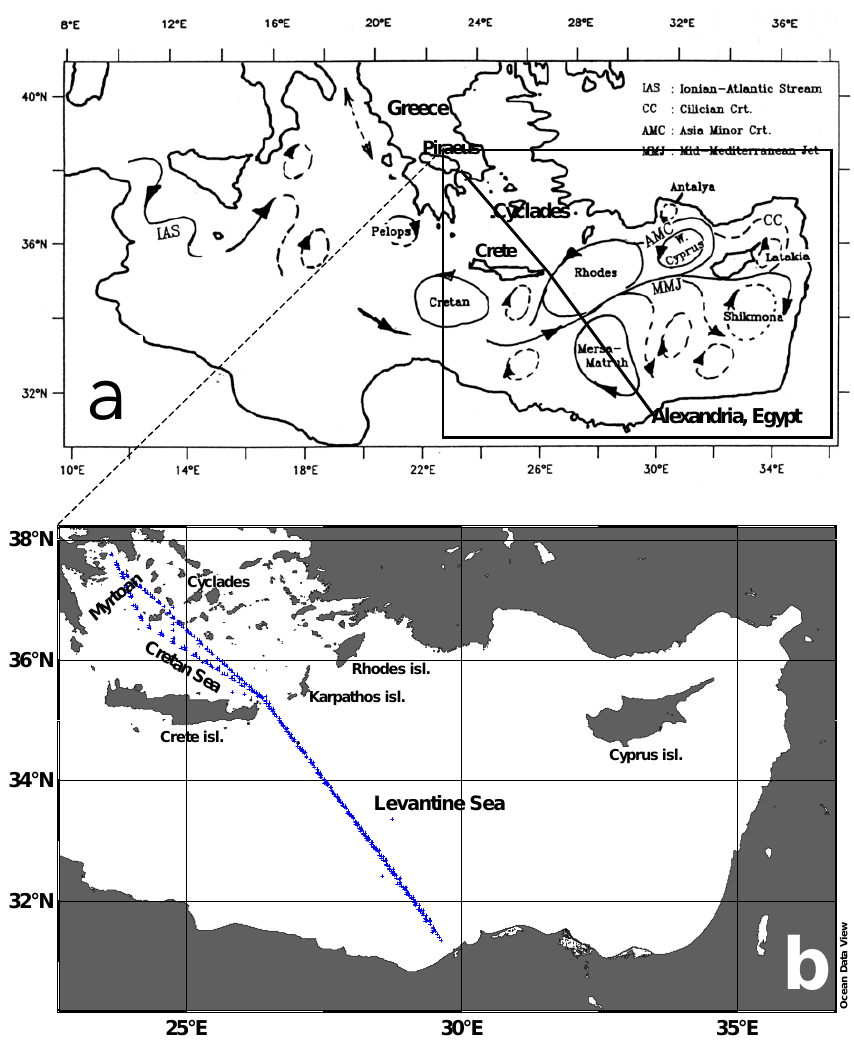
Fig. 1. (a) Schematic representation of the sub-basin scale circulation of the eastern Mediterranean, as estimated by Robinson et al. (1991) (from Zervakis et al., 2001). Solid (dashed) curves repre- sent permanent (transient) features. Su- perimposed on the figure by Robinson Cyprus isl. et al. is the Piraeus – Alexandria tran- sect. Also, the island of Crete and the Cyclades archipelago are identified. The small transient anticyclonic fea- ture between Rhodes and Cretan cy- clones is the Ierapetra eddy. (b) The two different ship-tracks are shown as series of expendable bathythermograph (XBT) launching positions. The Myr- toan, Cretan and Levantine Seas are identified on the